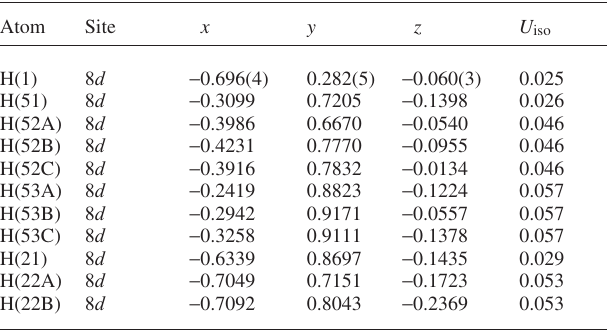
Table 2. Atomic coordinates and displacement parameters (in Å 2 ) . Table 2. Continued